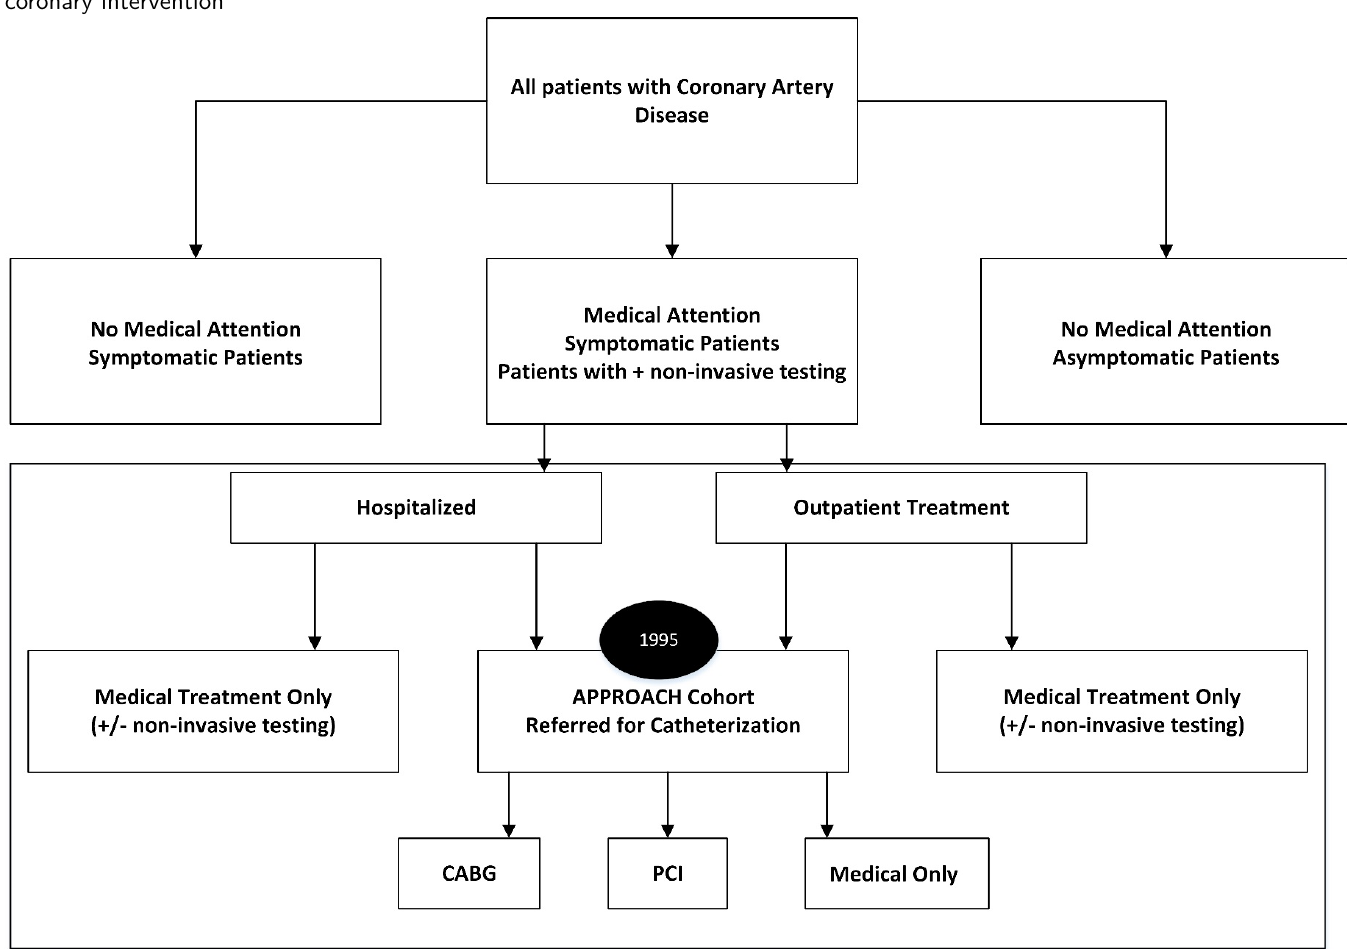
Figure 2: The scope of the Alberta Provincial Project for Outcome Assessment in Coronary Heart Disease (APPROACH) database – what it captures (enclosed within dotted lines) and what it does not capture. CABG Coronary artery bypass graft; PCI Percutaneous coronary intervention